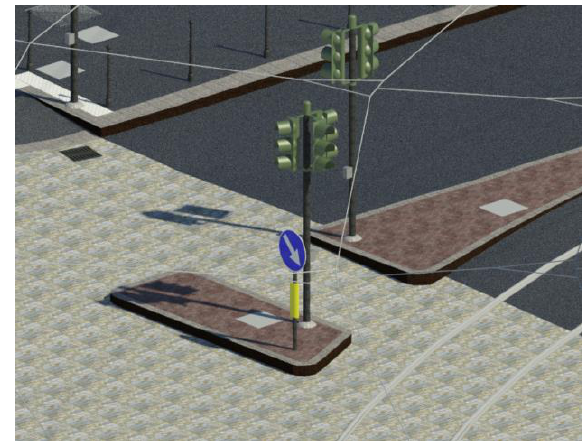
Figure 2. Image of the final BIM model with different paved areas integrated with the objects of urban spaces